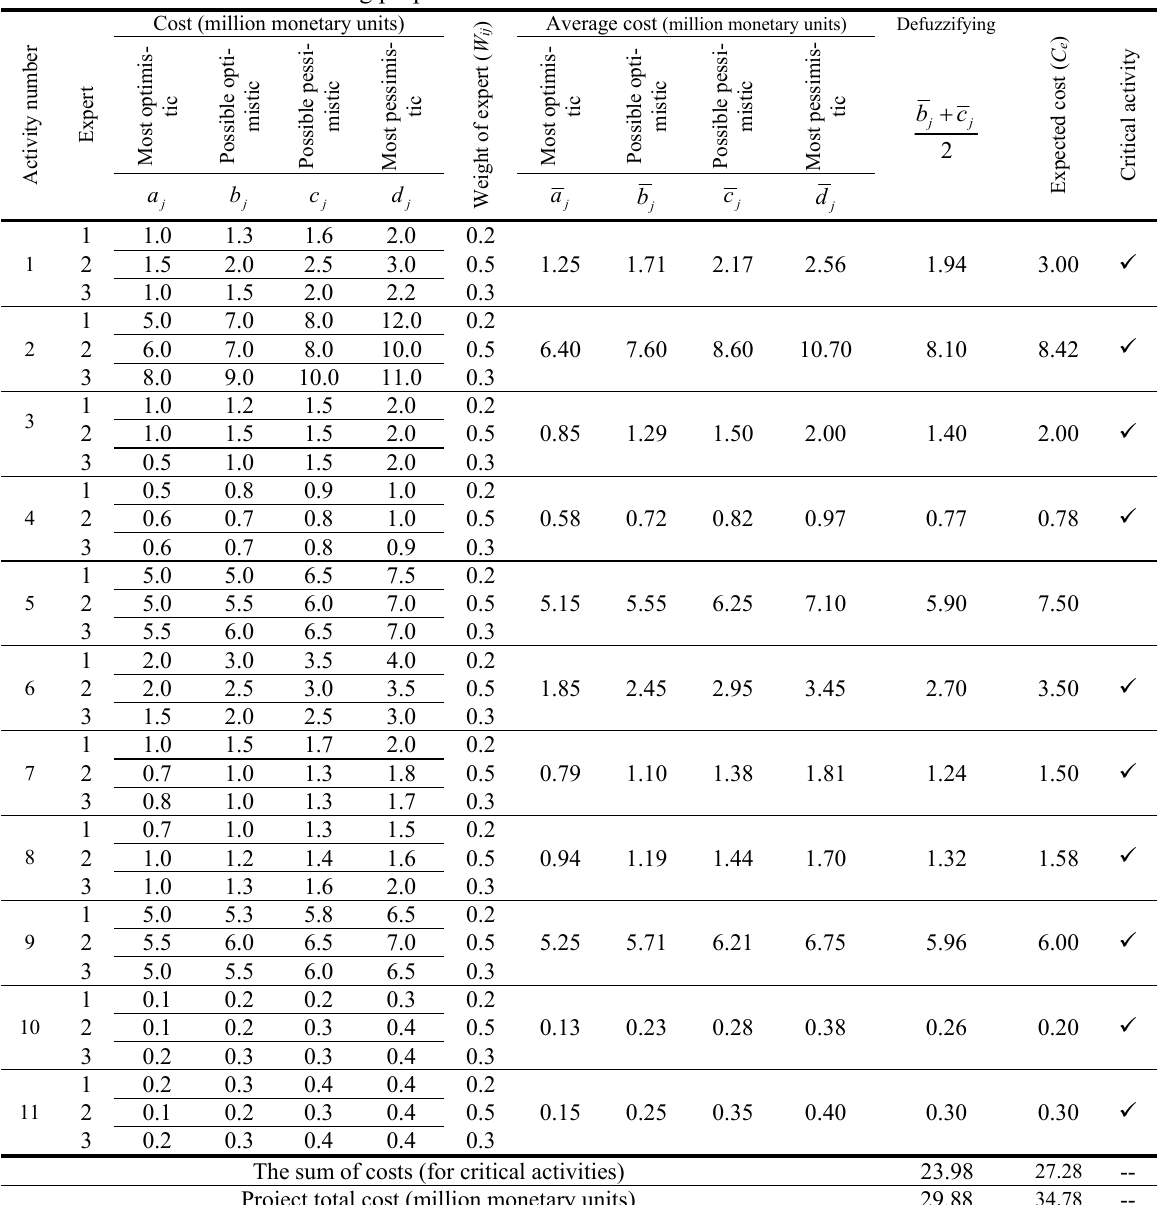
Calculation of activities cost using proposed